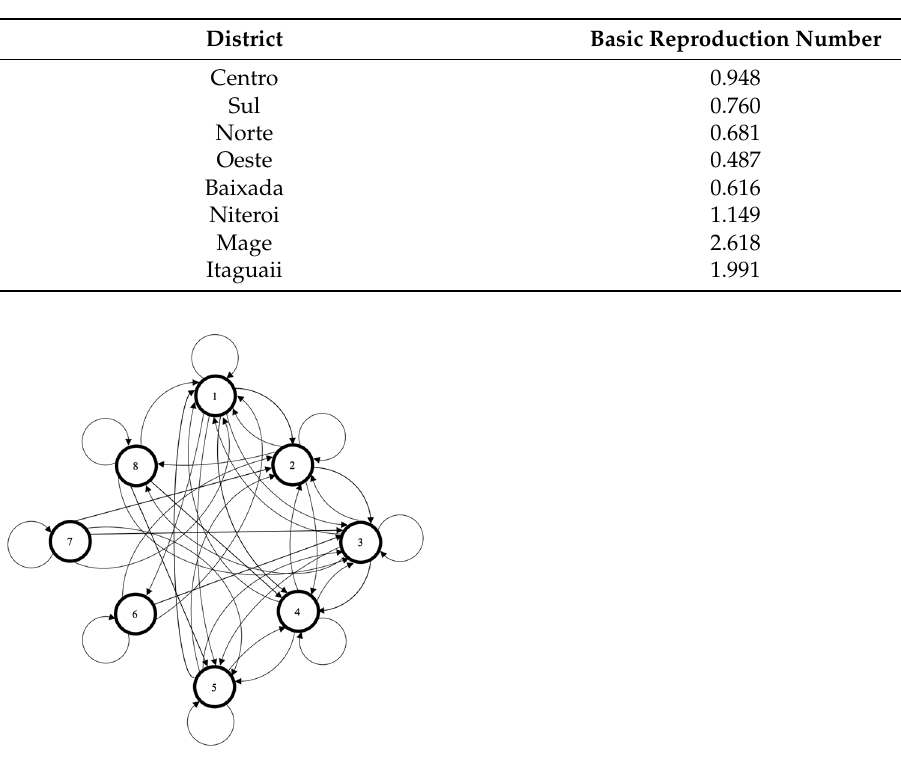
Table 2. The R 0 readings for the eight districts in Rio.